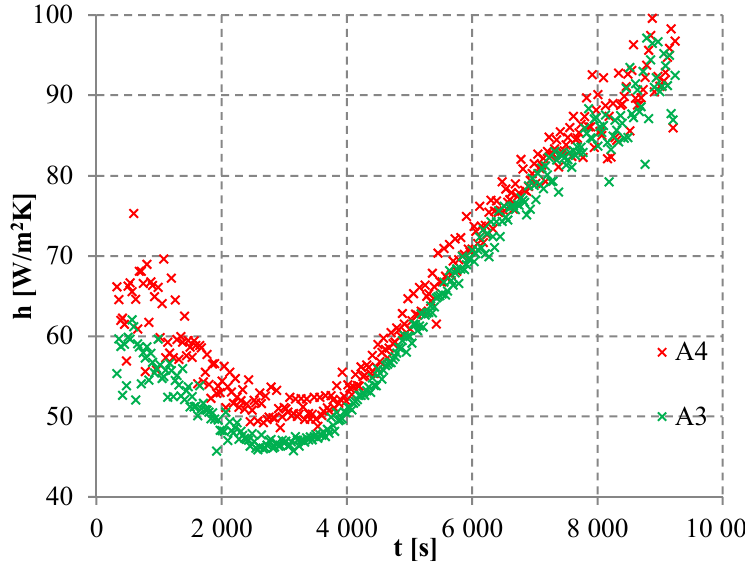
However, the character of the absolute difference (10) course close to the fan (plane A4) in process p2 was slightly different than in processes p1 and p5. It resulted from a more intensive heat flow close to the fan.